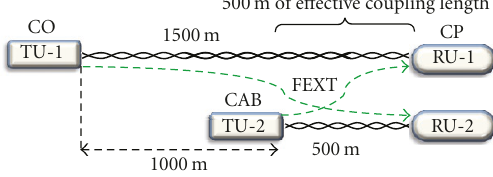
Figure 6: Access network Scenario I